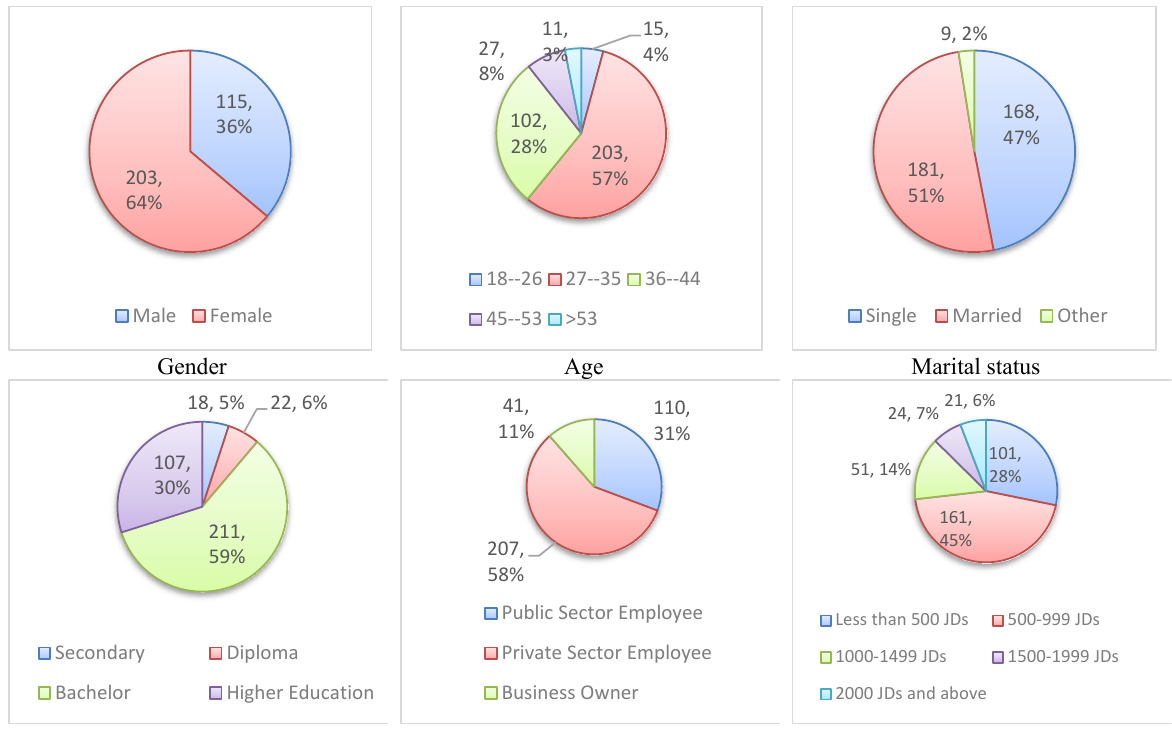
Fig. 2. Personal characteristics of the